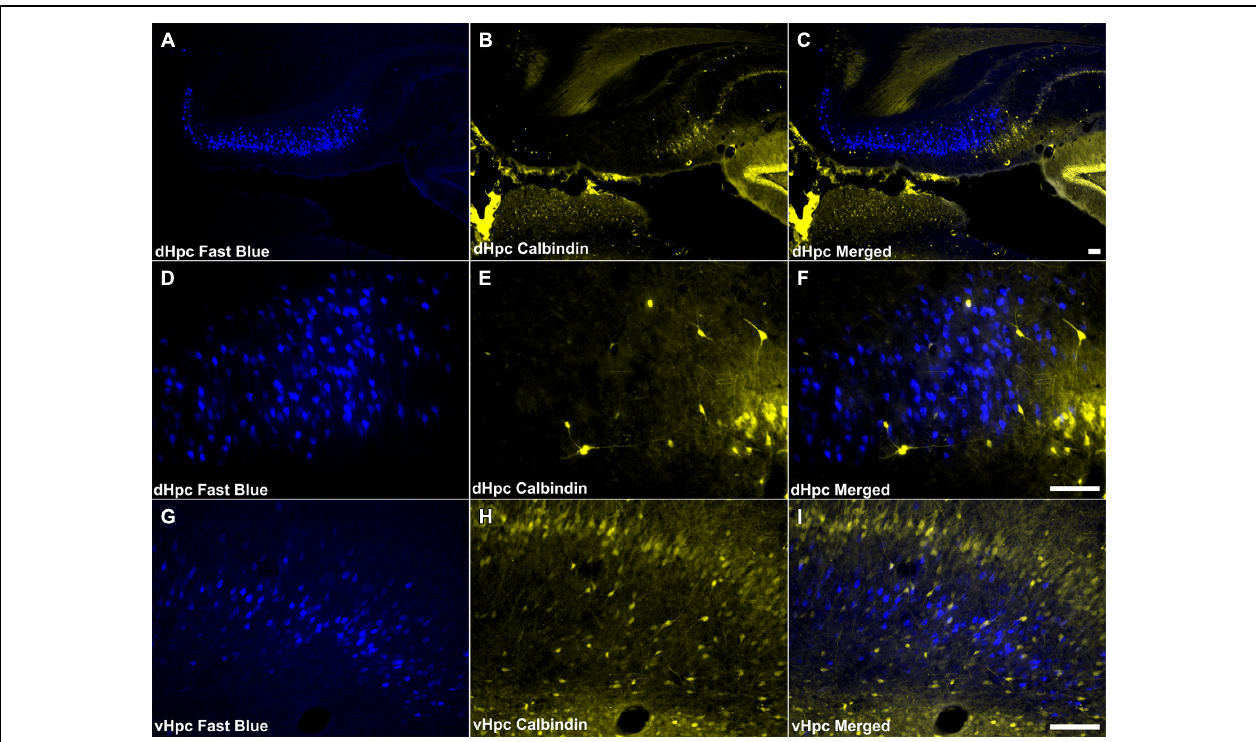
FIGURE 10 | Calbindin/hippocampal formation: (A,D,G) Fluorescent photomicrographs showing retrograde Fast Blue cell body label in the dorsal subiculum at low (50 × ) and high (200 × ) magnification, as well as the ventral subiculum (200 × ). (B , E , H) show fluorescent CB immunoreactivity in respective sections while (C , F , I) show retrograde Fast Blue label and CB